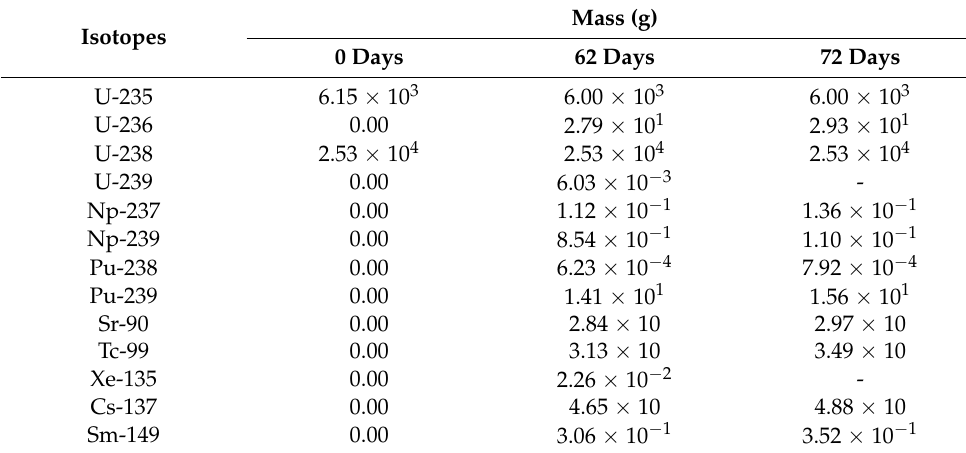
Table 6. MSTR-HPC’s significant radionuclide inventories.